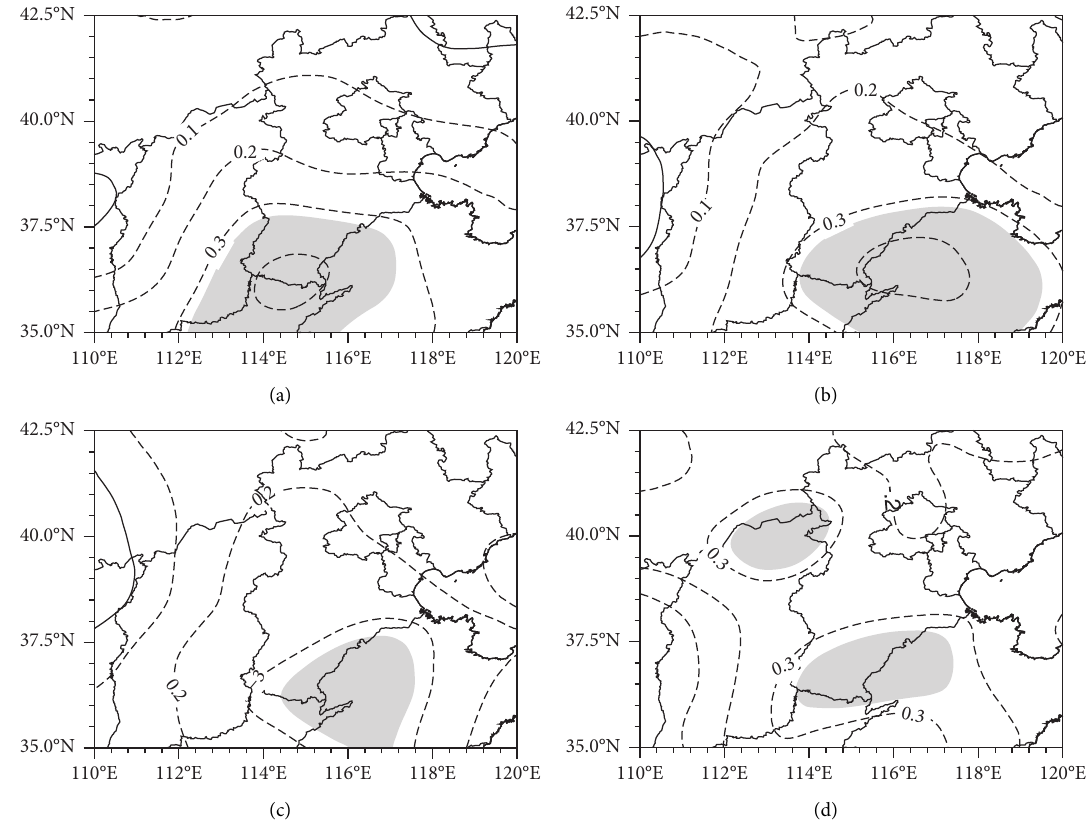
Figure 6: Correlation coefficients between I NP in summer (a), fall (b), and winter (c), I ATL in winter (d) and the SSECE frequency in North China in winter. The shaded regions represent statistical significance at the 90% confidence level using Student’s t